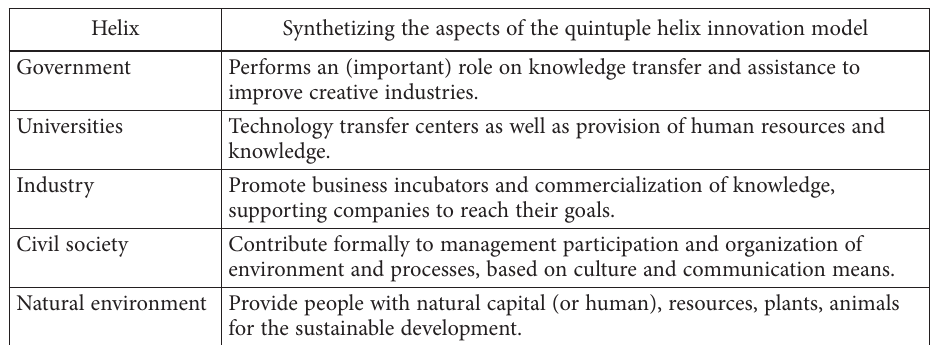
Table 2. Chart 2: quintuple helix innovation model (source: created by authors with a base on Etzkowitz & Leydesdorff (2000), Carayannis & Campbell (2010), Harwiki & Malet (2020))